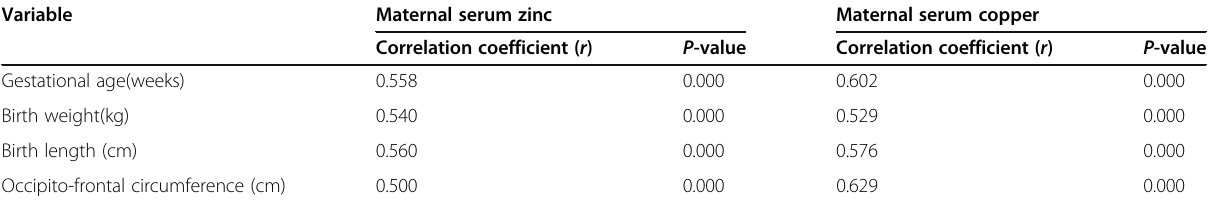
Table 4 Correlation of maternal serum zinc and copper levels with the anthropometric measurements in all the studied neonates